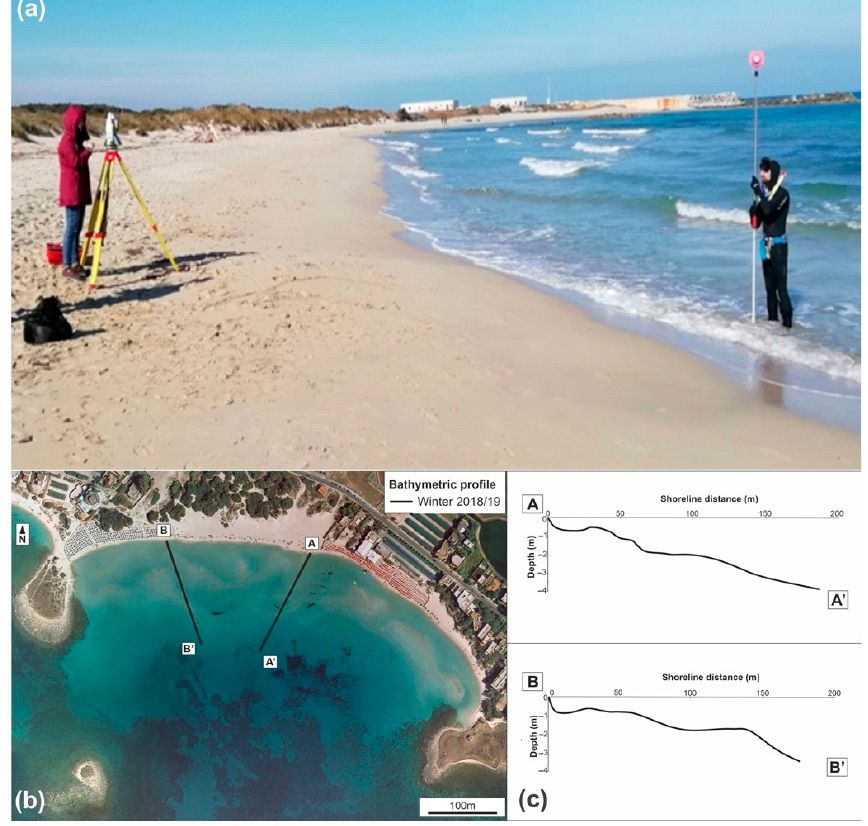
Figure 9. Example of OTS field surveys during winter 2018/19. ( a ) OTS instrument with the reflective system (prism) for bathymetric point measurement; ( b ) map showing the bathymetric transect location; ( c ) bathymetric profiles extrapolated from the measurement carried out in winter 2018/19.